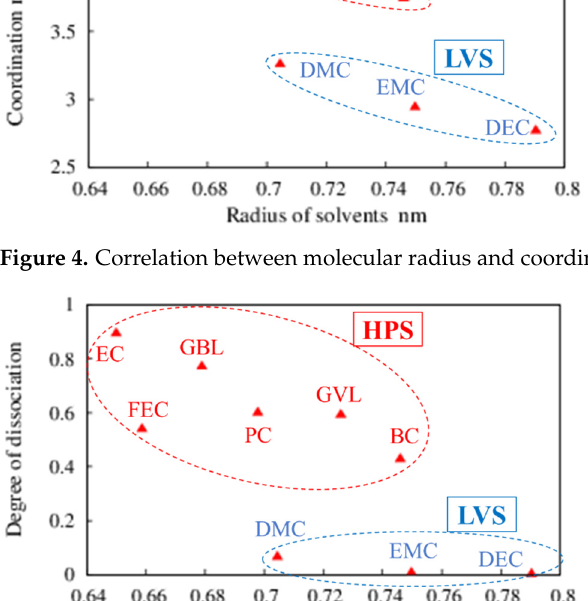
Figure 5. Correlation between molecular radius and degree of dissociation.